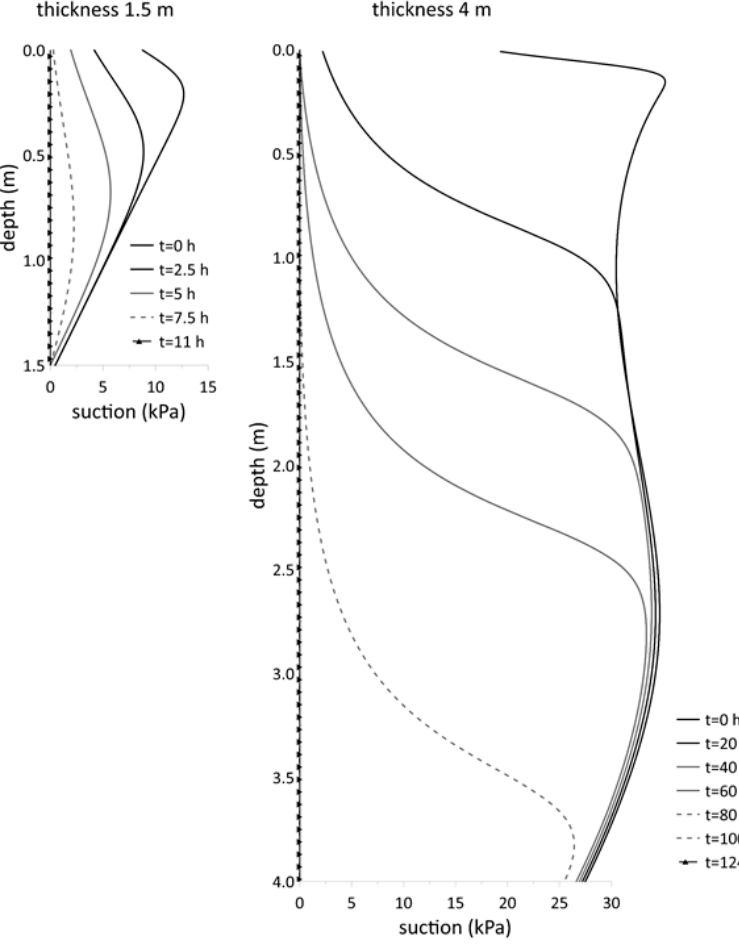
Figure 15. Results of set B analyses: temporary suction distribution computed for s uB0 = 70; ( a ) domain s 1.5 = 1.5 m; ( b ) domain s 4 = 4